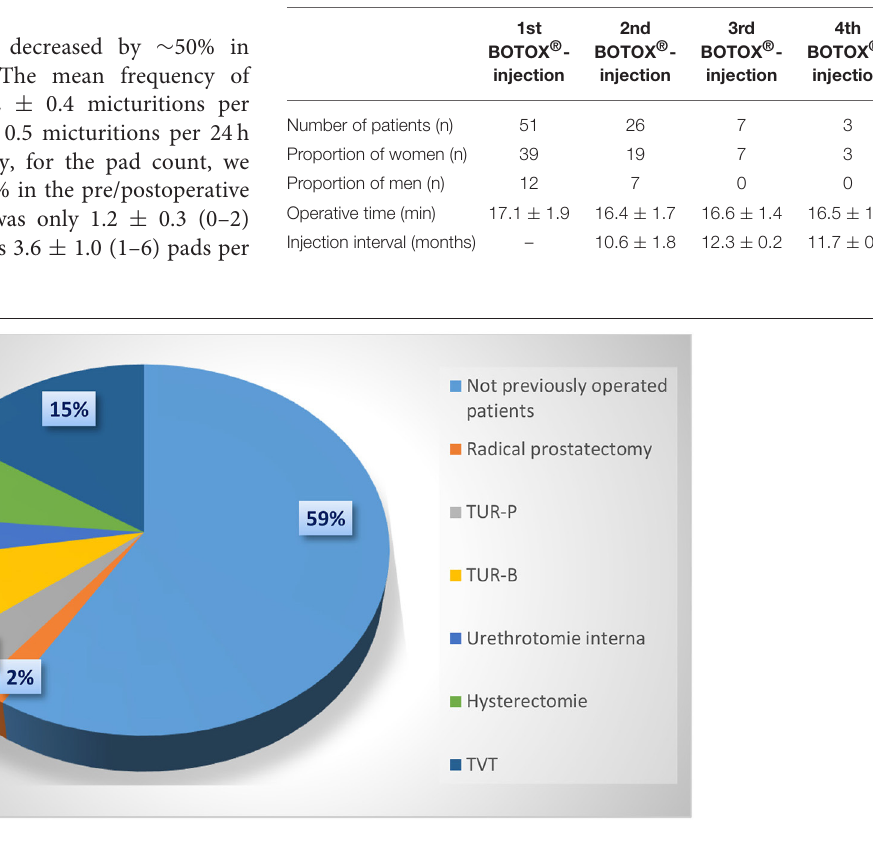
FIGURE 1 | Previous urogynecological surgery.